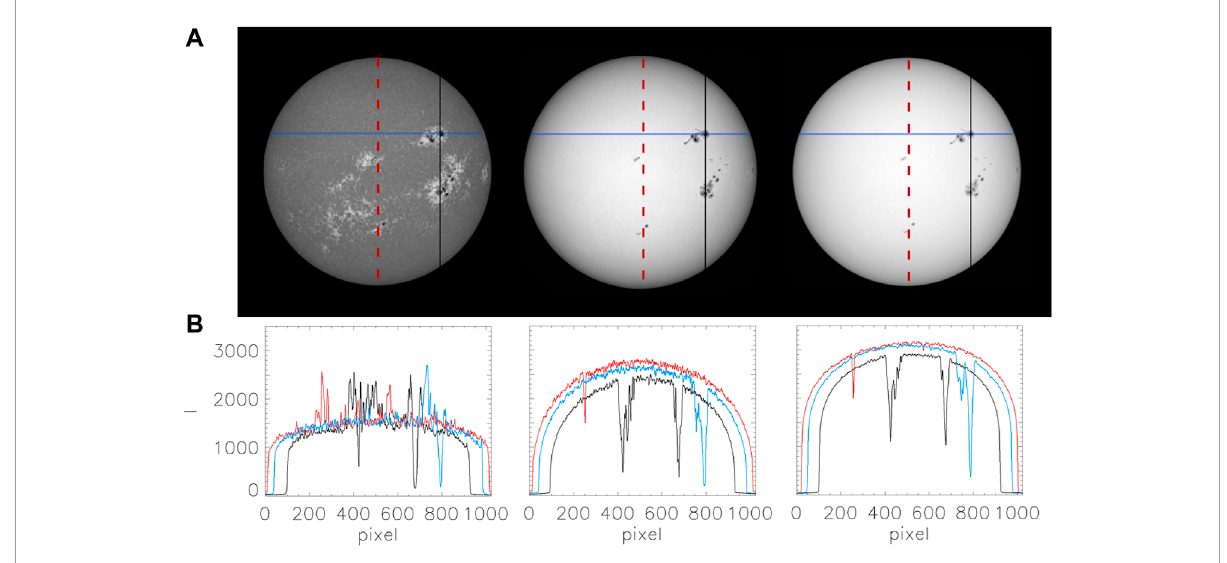
FIGURE 7 (A) Examples of the solar full-disk observations acquired with the Rome/PSPT on 31 October 2003 at the Ca II K line (left), blue continuum (middle), and red continuum (right). (B) Intensity profiles over linear segments (marked in the same color in the full-disk images) derived from the solar observation directly above